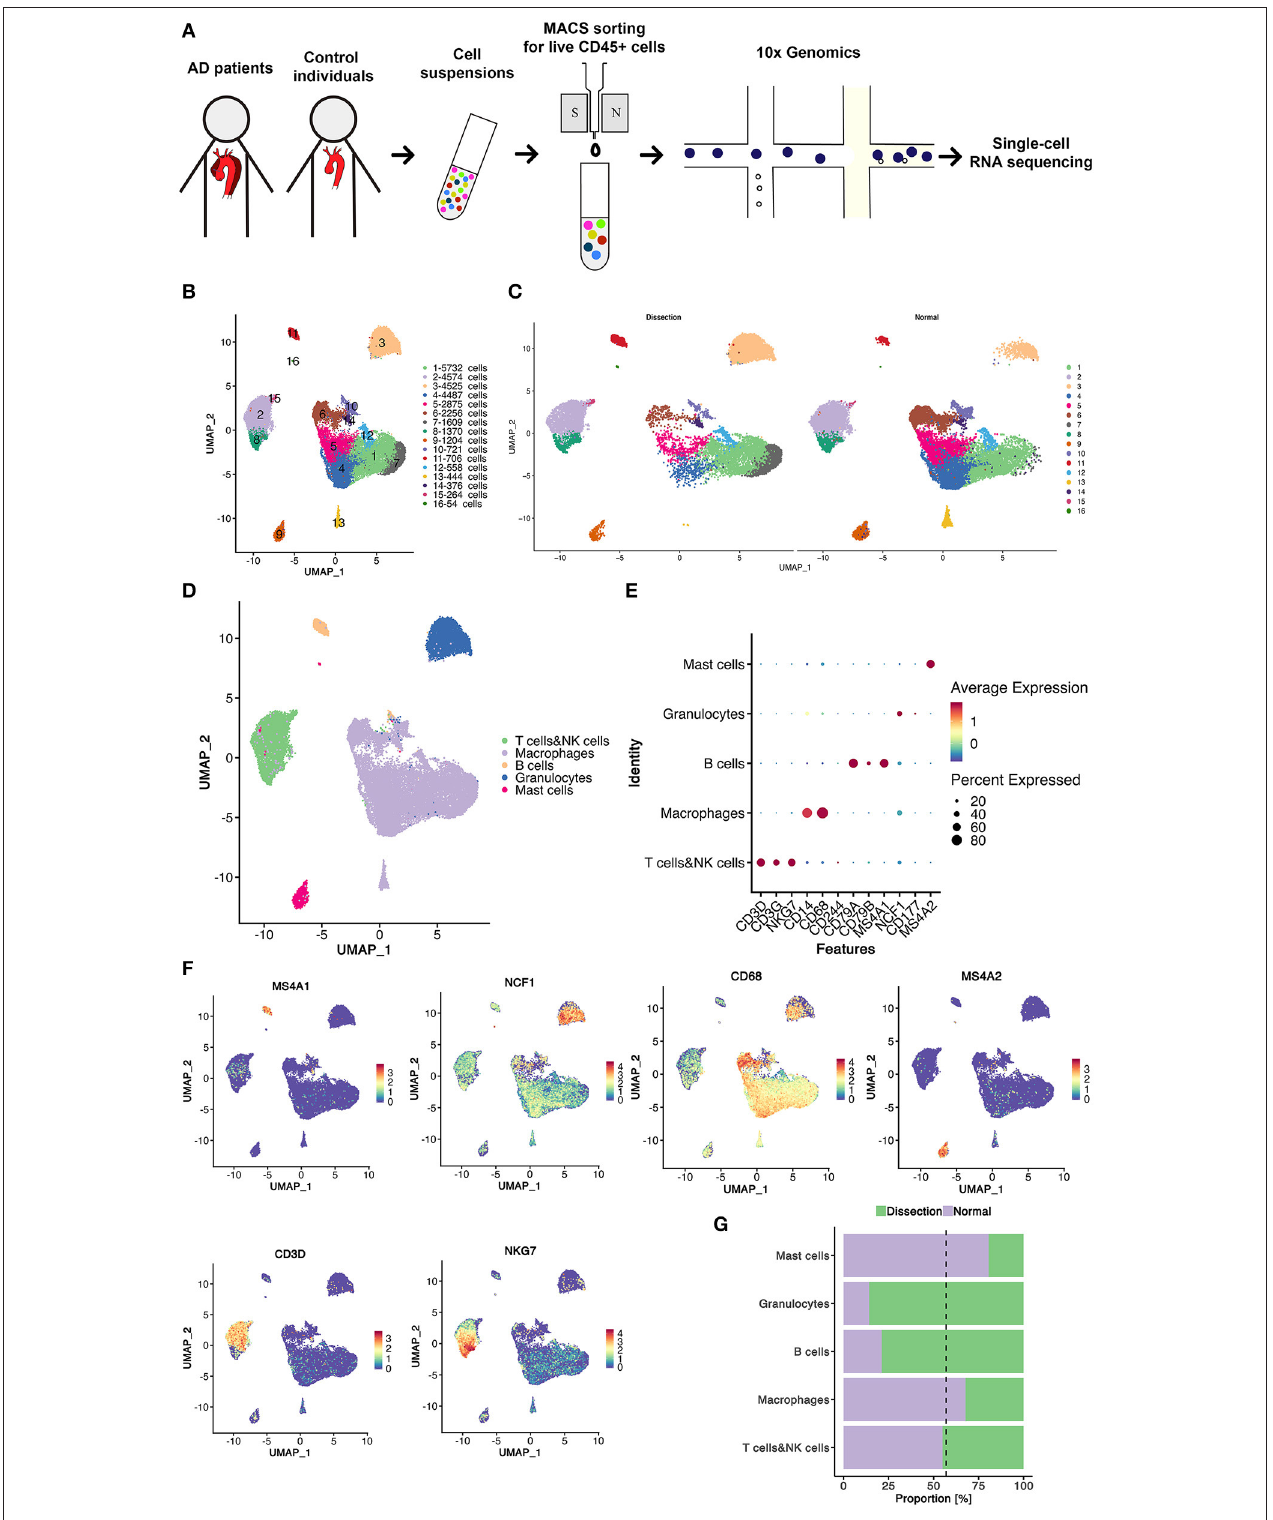
FIGURE 1 | Sixteen clusters of immune cells identified using scRNA-seq analysis of human thoracic aortic dissection tissues. (A) Experimental approach of the experimental setup. Thoracic aortic dissection tissues were collected from 3 patients with sporadic type A aortic dissection, and normal aortas were collected from 2 heart transplant donors. Samples were digested, and live CD45 + cells were sorted by MACS and loaded for scRNA-seq. (B) The UMAP plot representation of 31,755